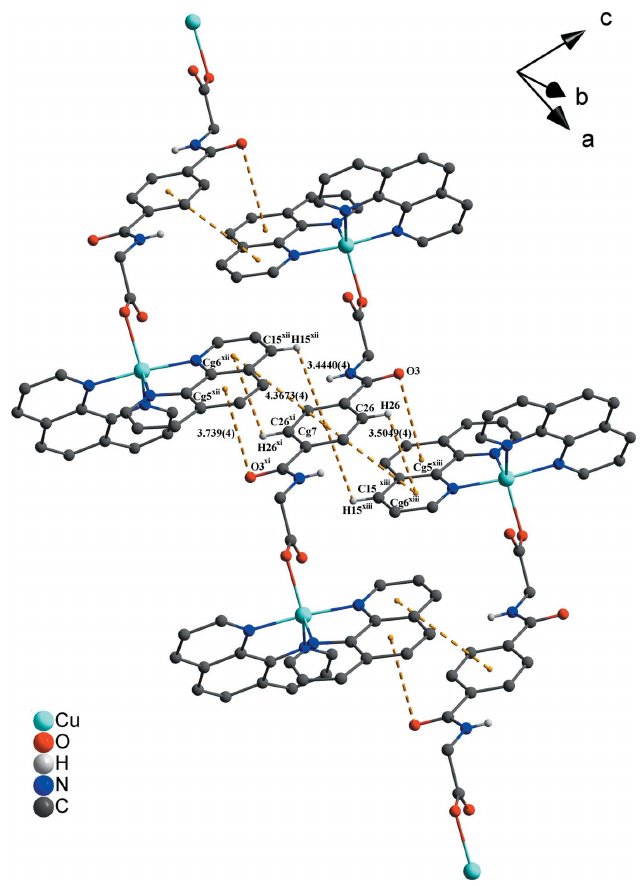
Figure 4 View of the lone-pair (cid:2)(cid:2)(cid:2) (cid:2) interaction and (cid:2) – (cid:2) stacking between the complex cation subunits. Non-covalent interactions are indicated by dark- yellow dashed lines. The hydrogen atoms not involved in interactions have been omitted for clarity. Distances are given in A˚ . [Symmetry codes: (xii) (cid:4) x + 1, (cid:4) y , (cid:4) z + 1; (xiii) x + 1, y , z distances are: 3.6515 (5) A˚ between Cg 1 (cid:2) (cid:2) (cid:2) Cg 2, 3.6831 (4) A˚ between Cg 2 (cid:2) (cid:2) (cid:2) Cg 4, 3.6686 (5) A˚ between Cg 3 (cid:2) (cid:2) (cid:2) Cg 4, and